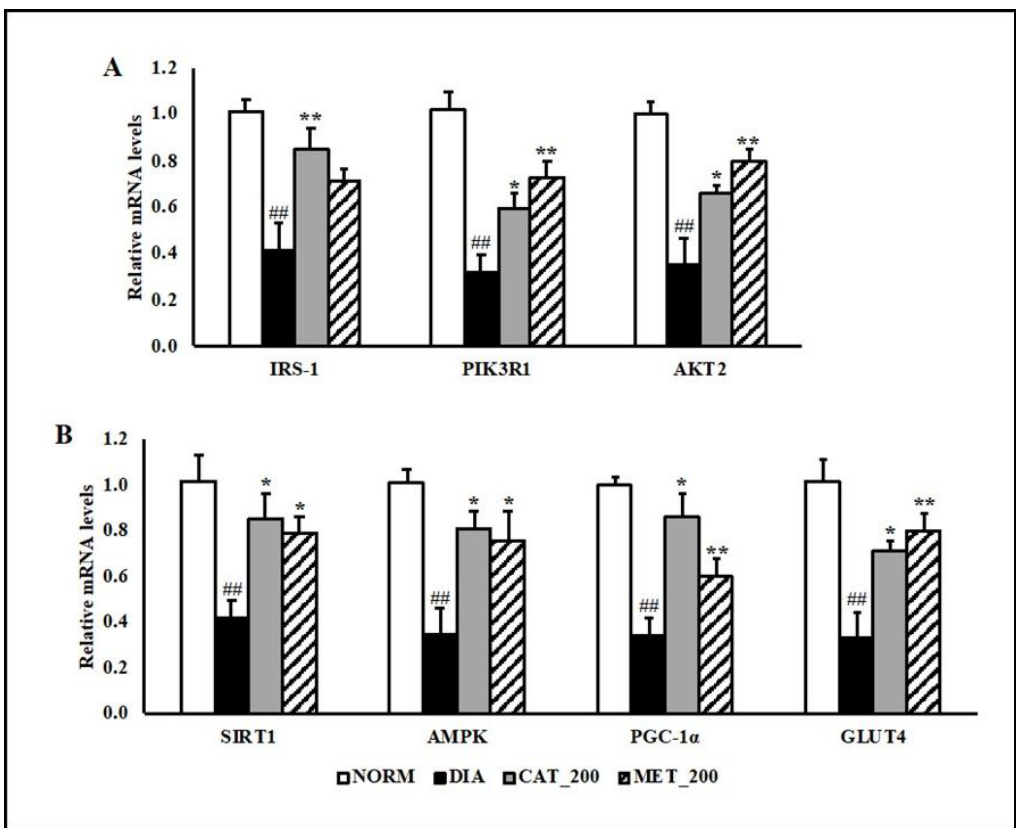
Figure 3. Effect of catalpol and metformin on expression of genes involved in insulin signaling pathways, AMPK, PGC-1α, SIRT1 and GLUT4 in skeletal muscle (gastrocnemius and soleus muscle) ( A ) genes involved in insulin-signaling pathway ( B ) AMPK-SIRT1-PGC-1α-GLUT4 pathway in skeletal muscles. NORM: Normal control; DIA: Diabetic control; CAT_200: Catalpol (200 mg/kg; p.o.); MET_200: Metformin (200 mg/kg, p.o.). Data represents mean ± SEM ( n = 6–8). ## p < 0.01 vs. NORM; * p < 0.05 and ** p < 0.01 vs. DIA.